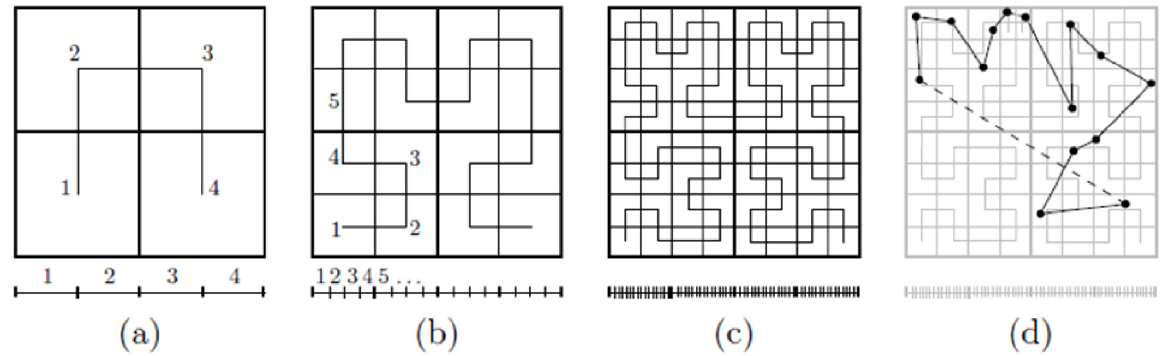
Figure 8: Hilbert’s curve and Order (taken from (Kevin, 2008))